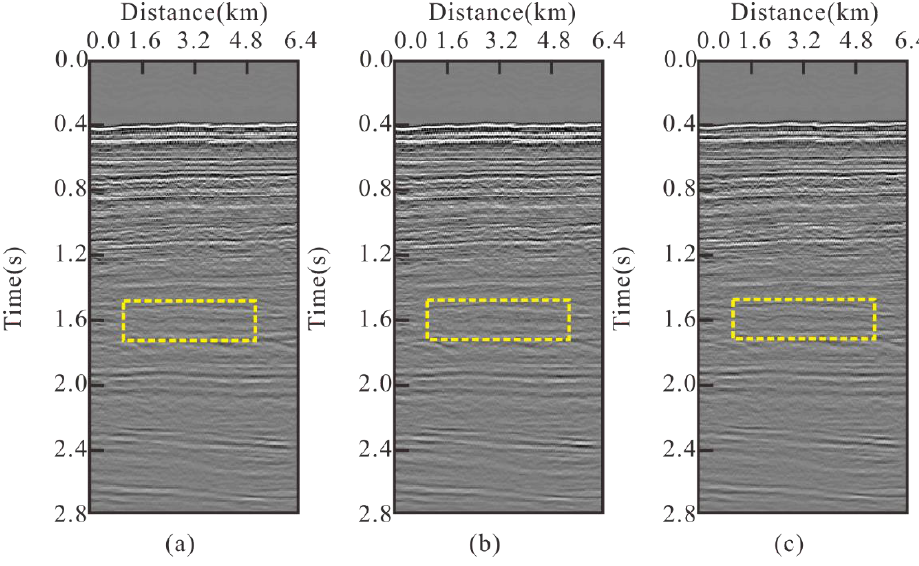
Figure 10. Comparison of stacked sections: ( a ) stack result of reference velocity, ( b ) stack result of the velocity obtained by control group, ( c ) stack result of the velocity obtained by proposed method.